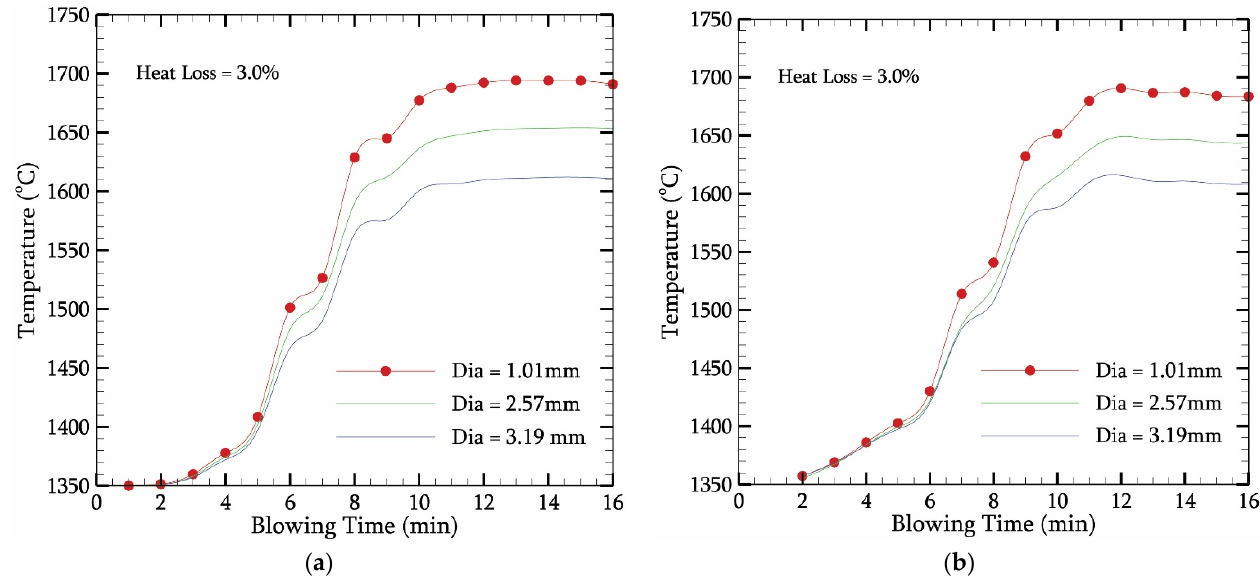
Figure 10. Effect of droplet diameter on ( a ) slag ( b ) hot metal temperature for a heat loss of 3%.